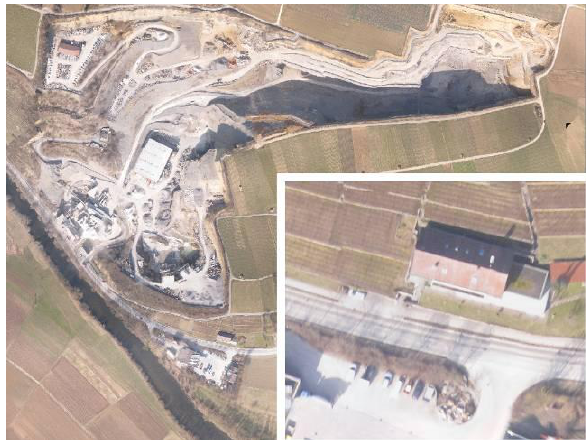
Figure 10: UAV ortho image (flown in March 2011).